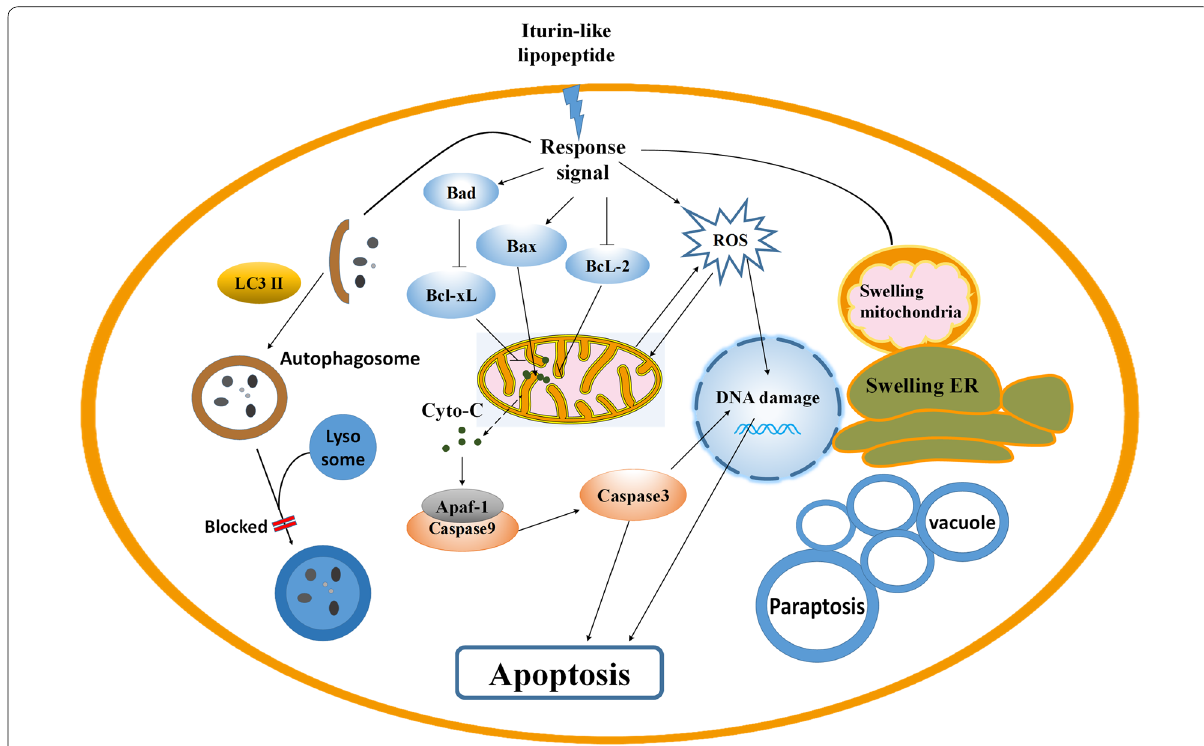
Fig. 10 Overall mechanisms of the inhibitory effect of Bacillus lipopeptides on